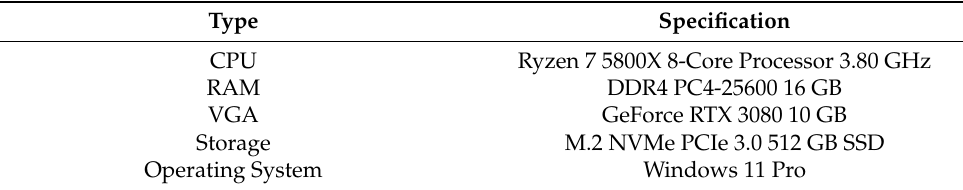
Table 2. Hardware specifications in the experiments.